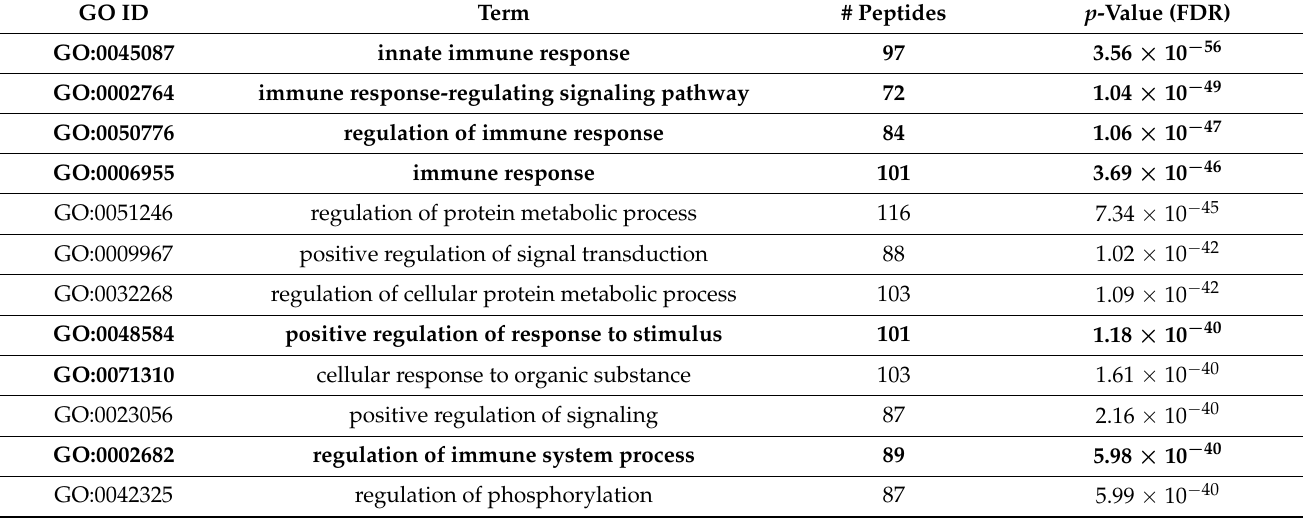
Table 3. The top 12 GO biological processes in sub-iliac lymph nodes collected from cattle at slaughter that were culture positive or negative for Salmonella . A list of representative GO terms was produced using the statistically significant peptides generated from the comparison of Salmonella -positive and -negative lymph nodes that were inputted into the online STRING database. The top 12 terms from the input data are listed. The pathways in bold are those involved in the immune response (total immune peptides: